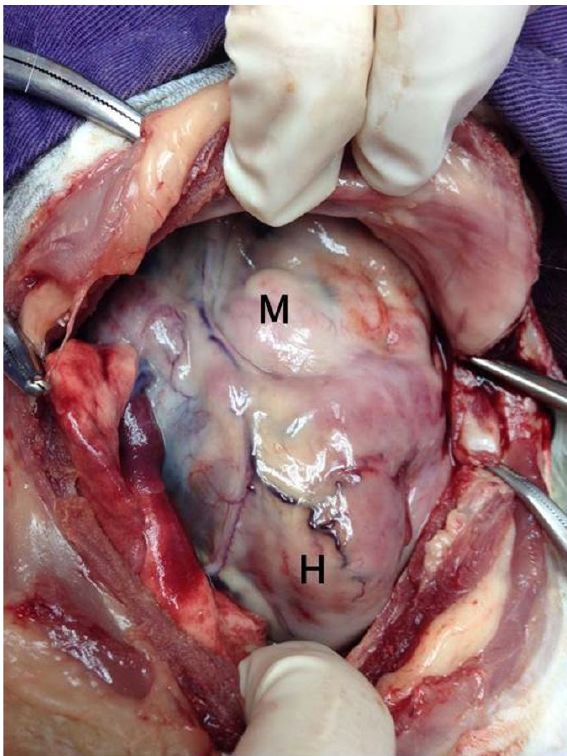
Figure 2. Macroscopic view of the mass (M) attached to the heart (H) after opening of the thoracic